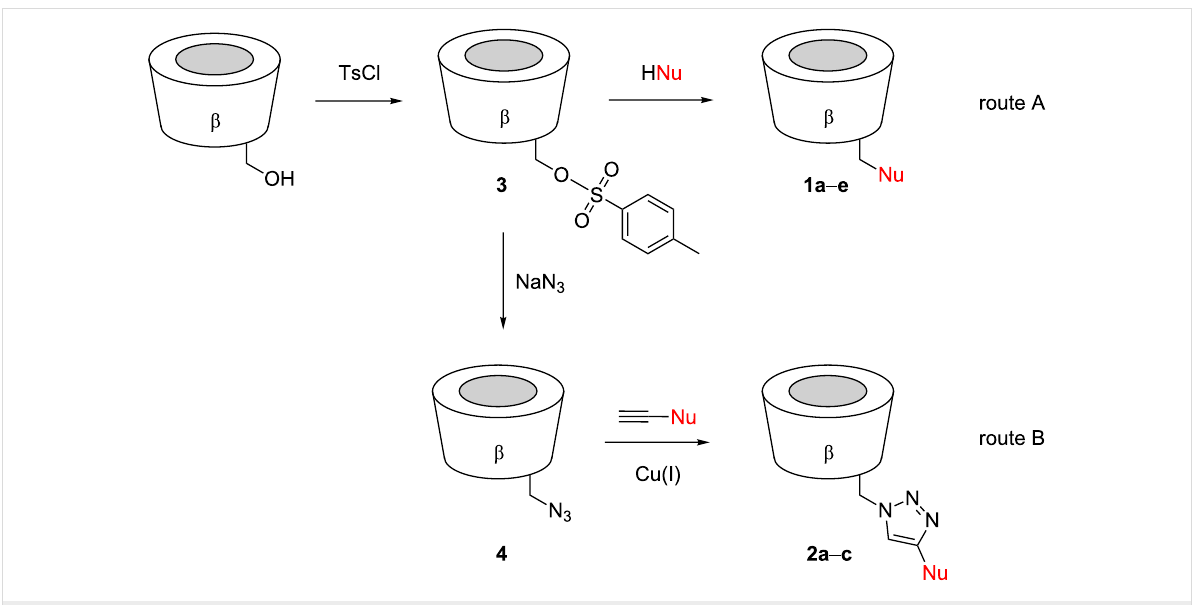
Scheme 3: General strategies used for the preparation of the investigated cyclodextrin derivatives.